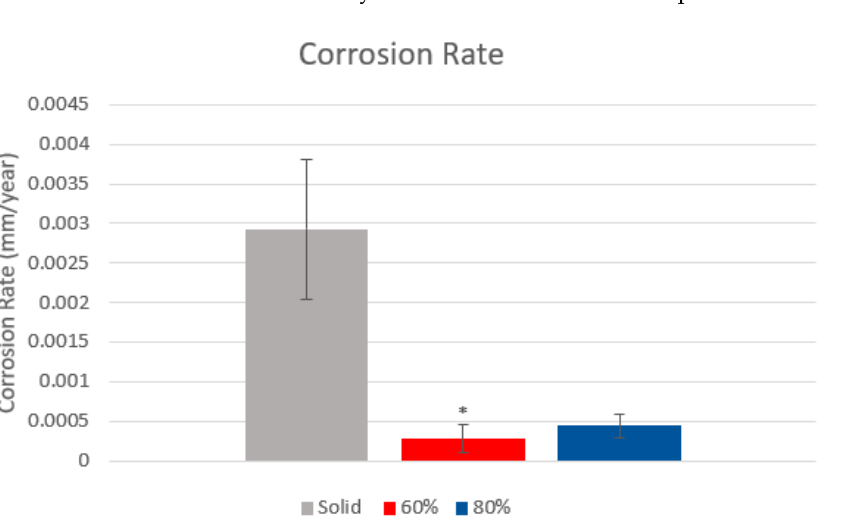
Figure 4. Average calculated Tafel corrosion rate of samples, with solid samples shown in grey, 80% porous gyroid in blue and 60% porous gyroid samples in red. * Indicates 60% samples having statistical significance to solid samples ( p < 0.05) whilst 80% porous samples having p = 0.0532. (One-way ANOVA, Tukey).